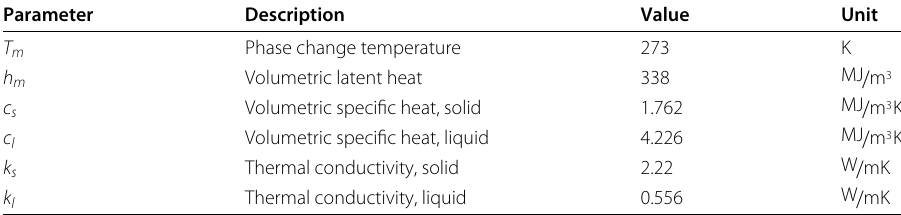
Table 1 Material parameters of water [40] for “Solidification front in a 1D slab” and “Melting volume in a 1D slab”